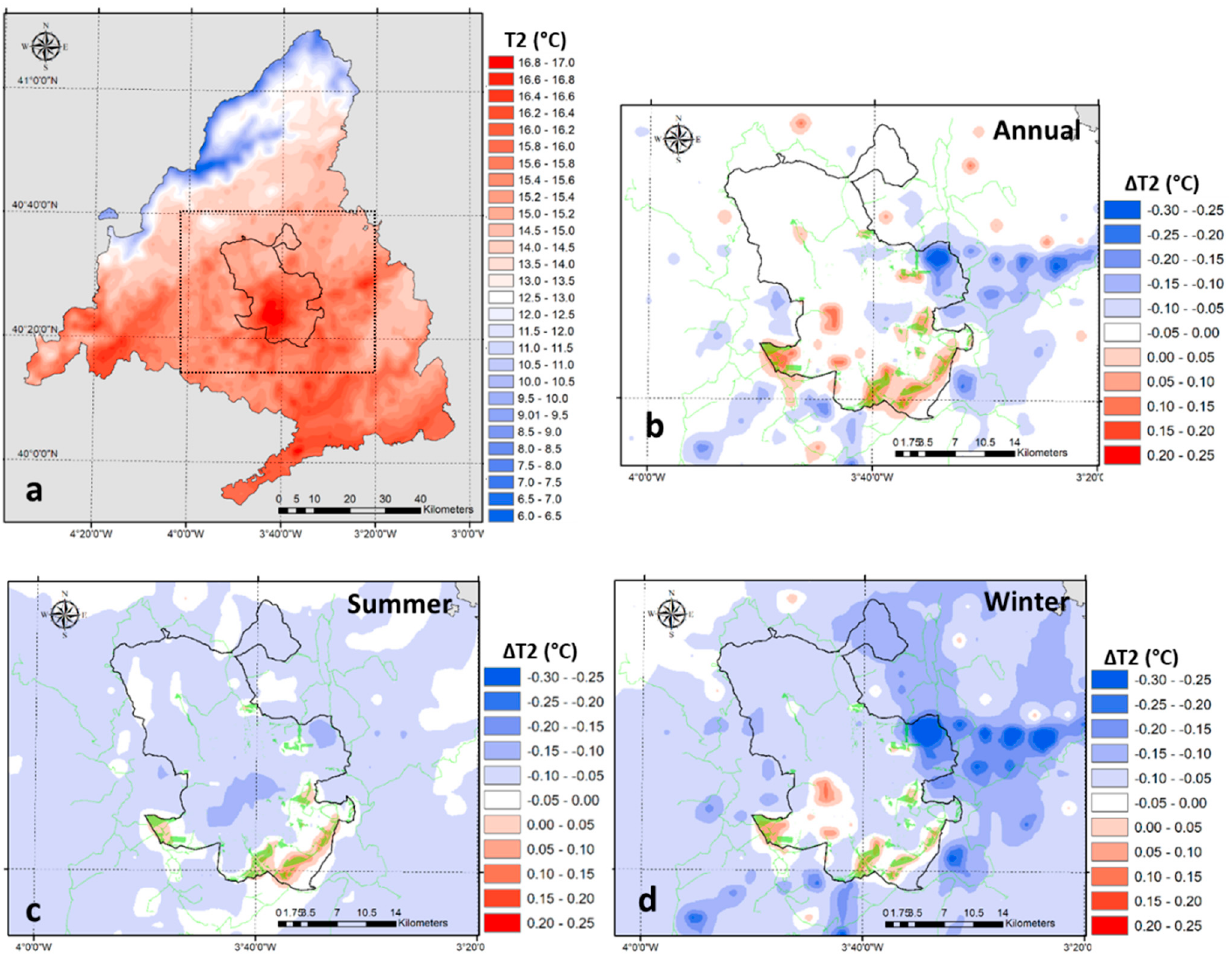
Figure 4. Annual mean temperature for the Baseline Scenario ( a ). Expected variation in temperature: annual mean ( b ), summer mean ( c ) and winter mean ( d ), due to future vegetation.